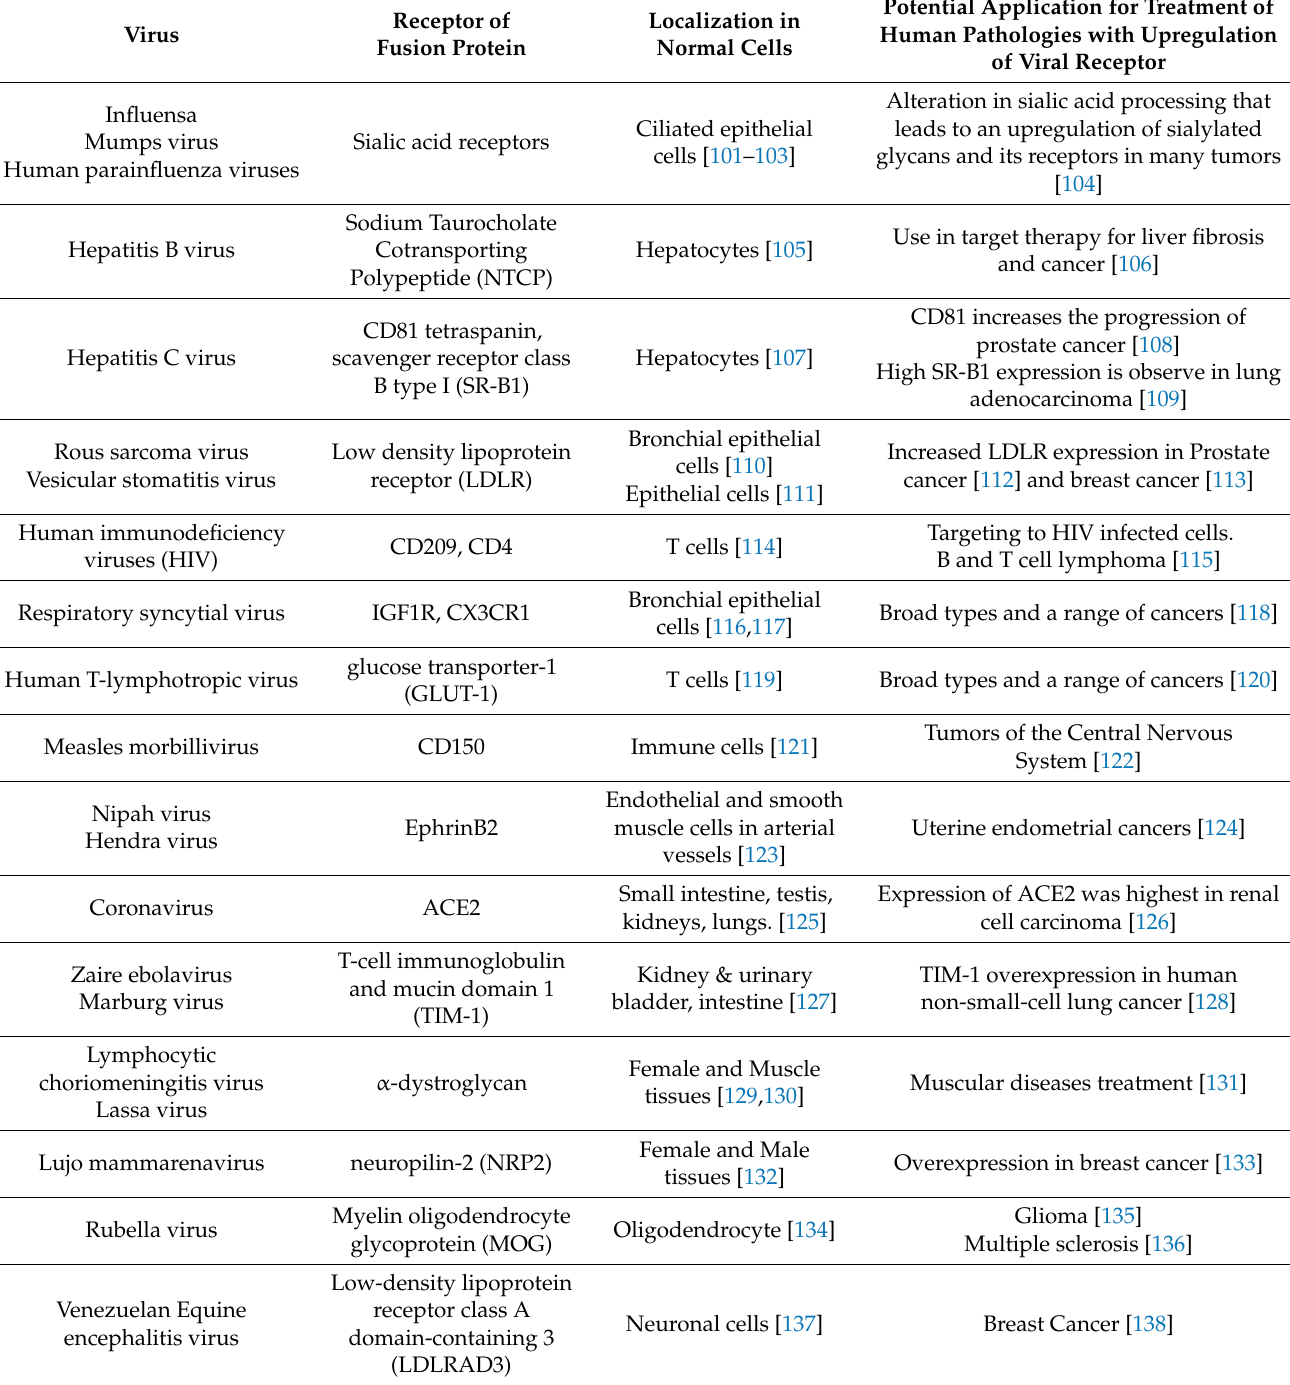
Table 2. Viral receptors and its potential application for treatment of human pathologies with overexpression of viral